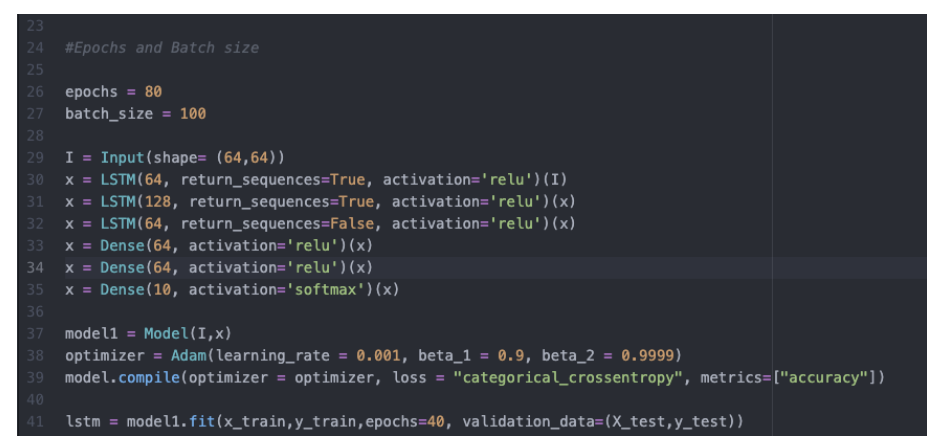
Figure 16. Building the LSTM